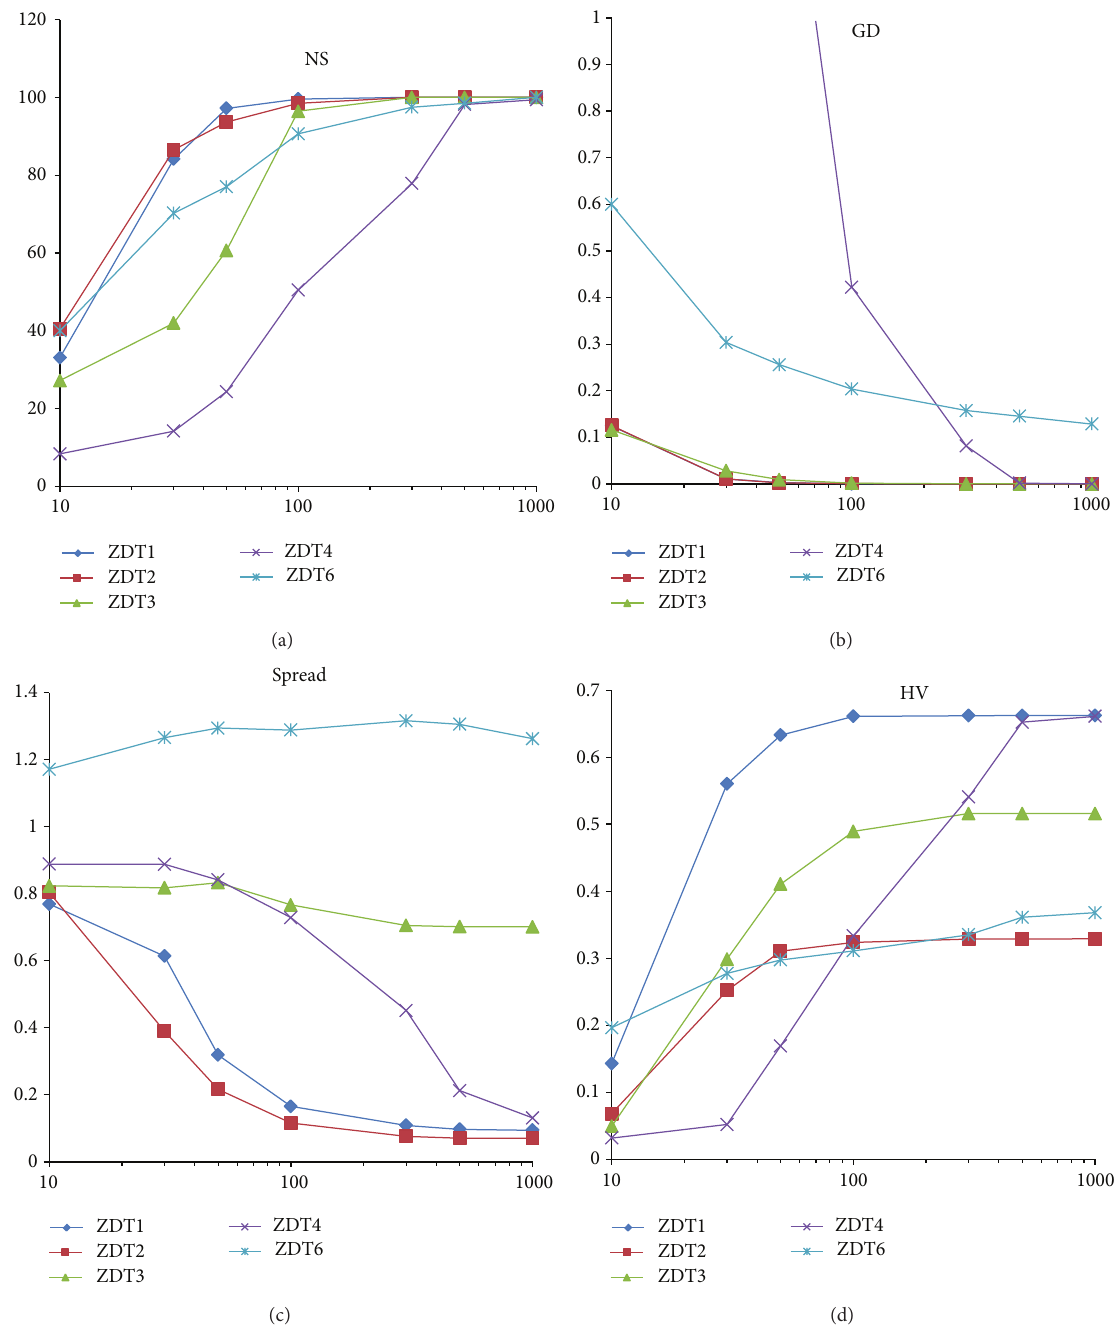
Figure 11: Plots of the performance measures versus numbers of particles. (a) Number of solutions. (b) Generational distance. (c) Spread. (d)